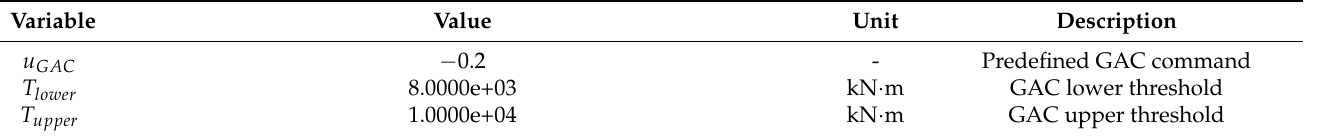
Table A3. GAC controller